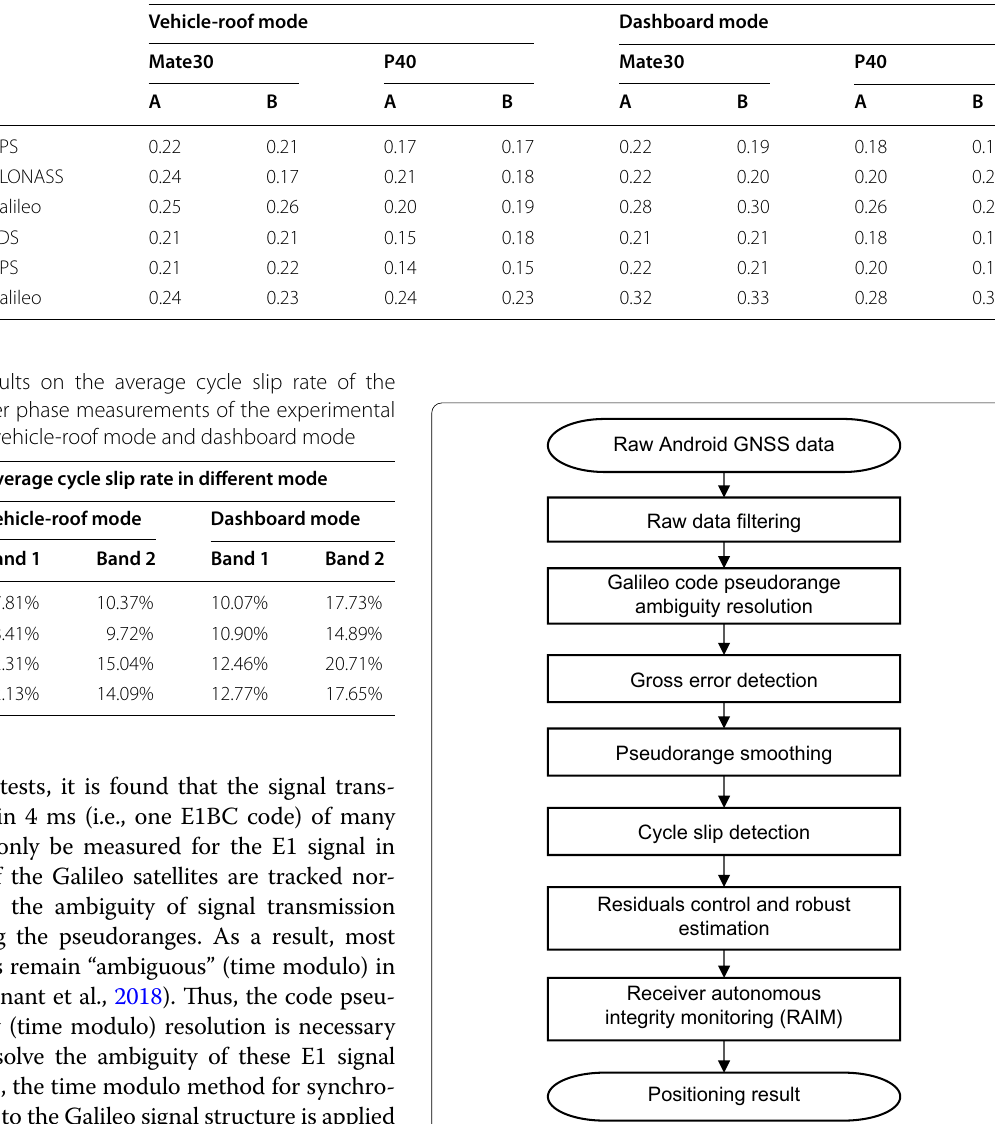
Fig. 9 The flow diagram for data quality control in smartphone